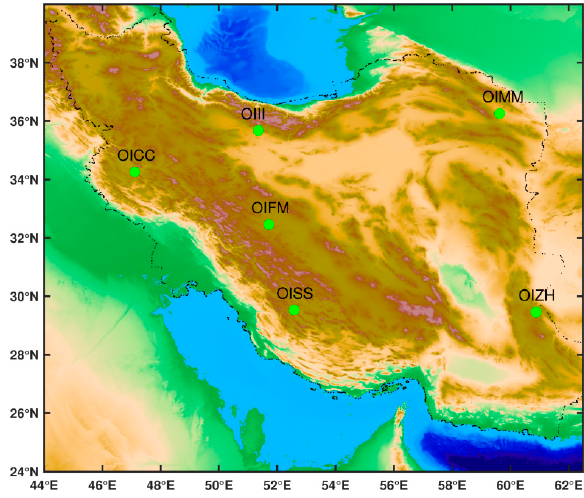
Figure 5. Locations of the six radiosonde stations used in this study.